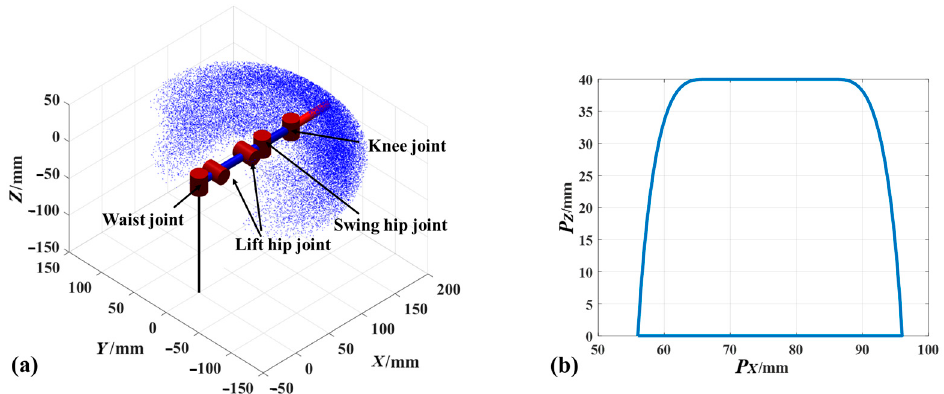
Figure 4. Movement of leg and foot: ( a ) workspace of leg and ( b ) wobble phase of foot.